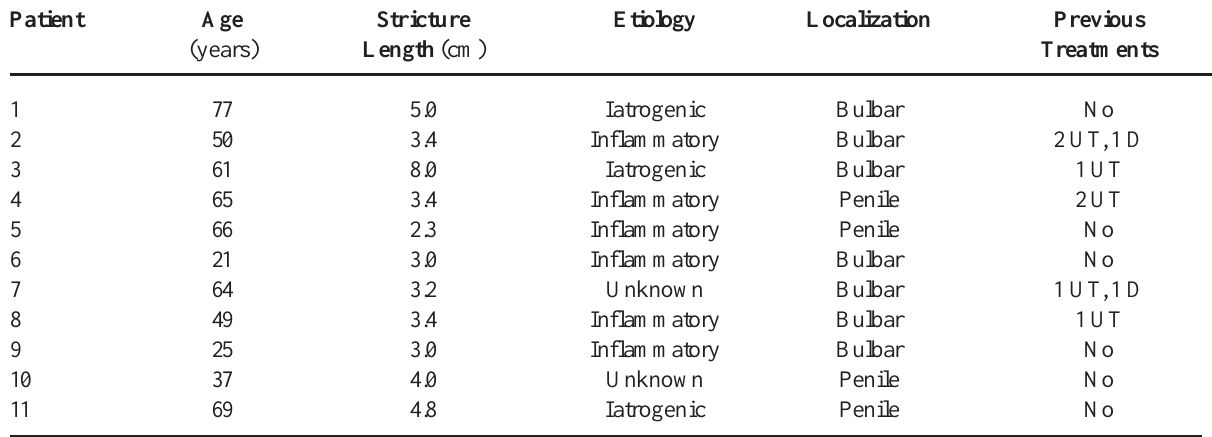
Table 1 – Clinical data of the patients.